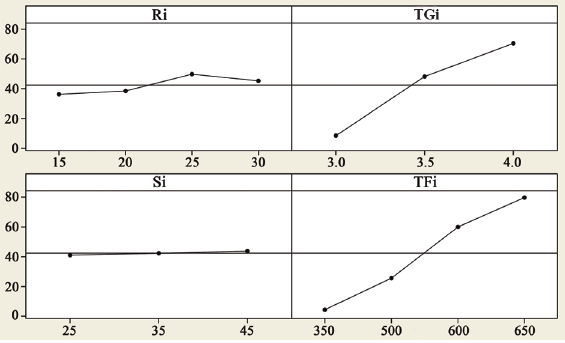
Fig. 3. Main plots for stop-line delays in R simulations with running time of one hour for each simu- lation) in order to provide a 95% confidence in stop-line delays with a confidence interval of ± 1.00 s.